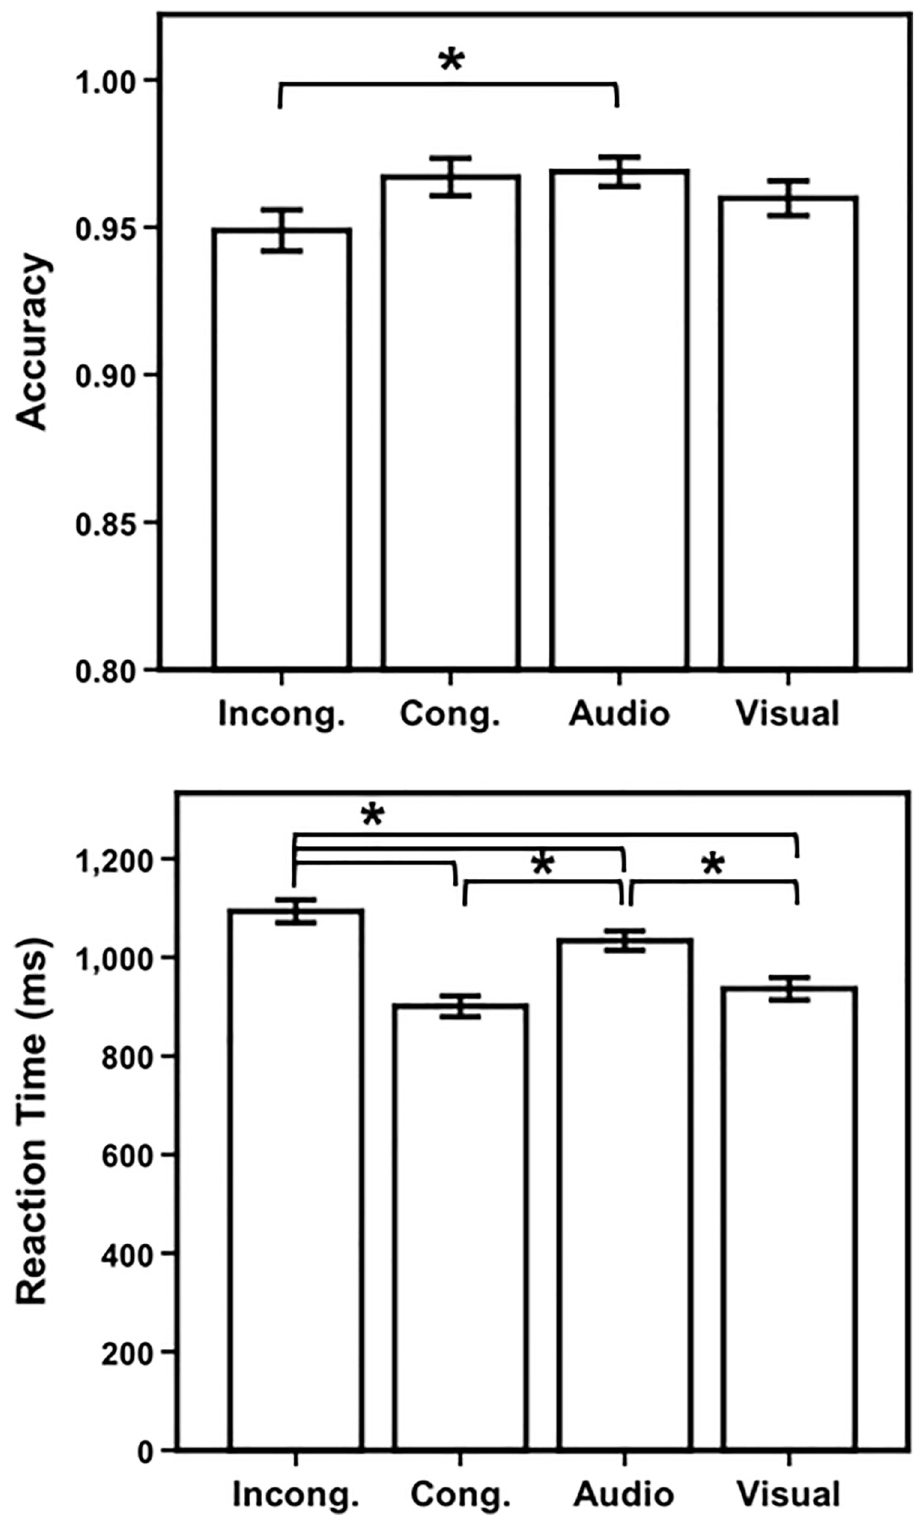
Fig 2. Accuracy and reaction time results from experiment 1. Average accuracy (displayed as proportion correct) and reaction time in milliseconds for each AV Stroop task condition for the behavioral participants (n = 29) in